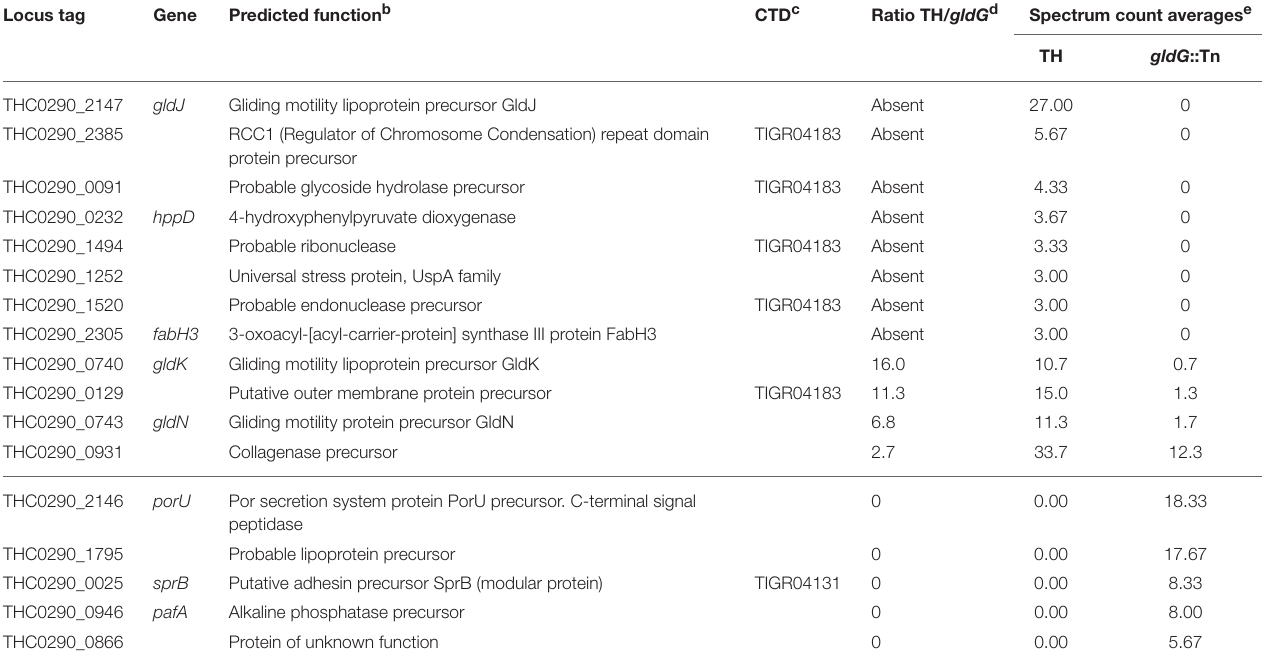
TABLE 5 | Surfome of strains THCO2-90 and gldG::Tn identified by LC-MS/MS analysis a . Locus tag Gene Predicted function b